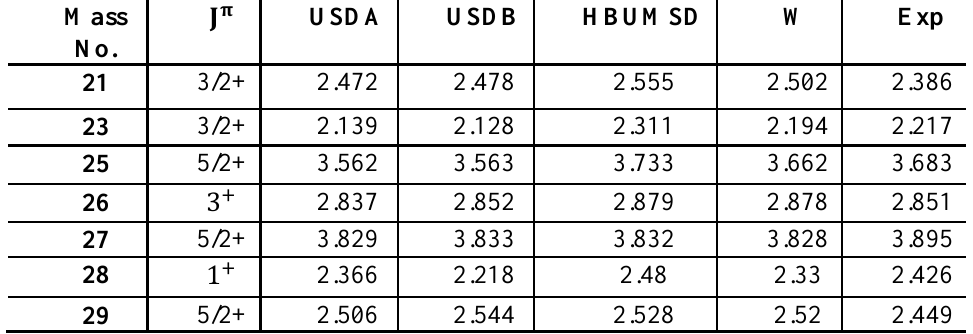
Table 1: Theoretical calculated of magnetic dipole moments μ (nm) for -isotopes using four two-body effective interactions; USDA, USDB, HBUMSD and W in comparison with the experimental data from Ref [16, 17].